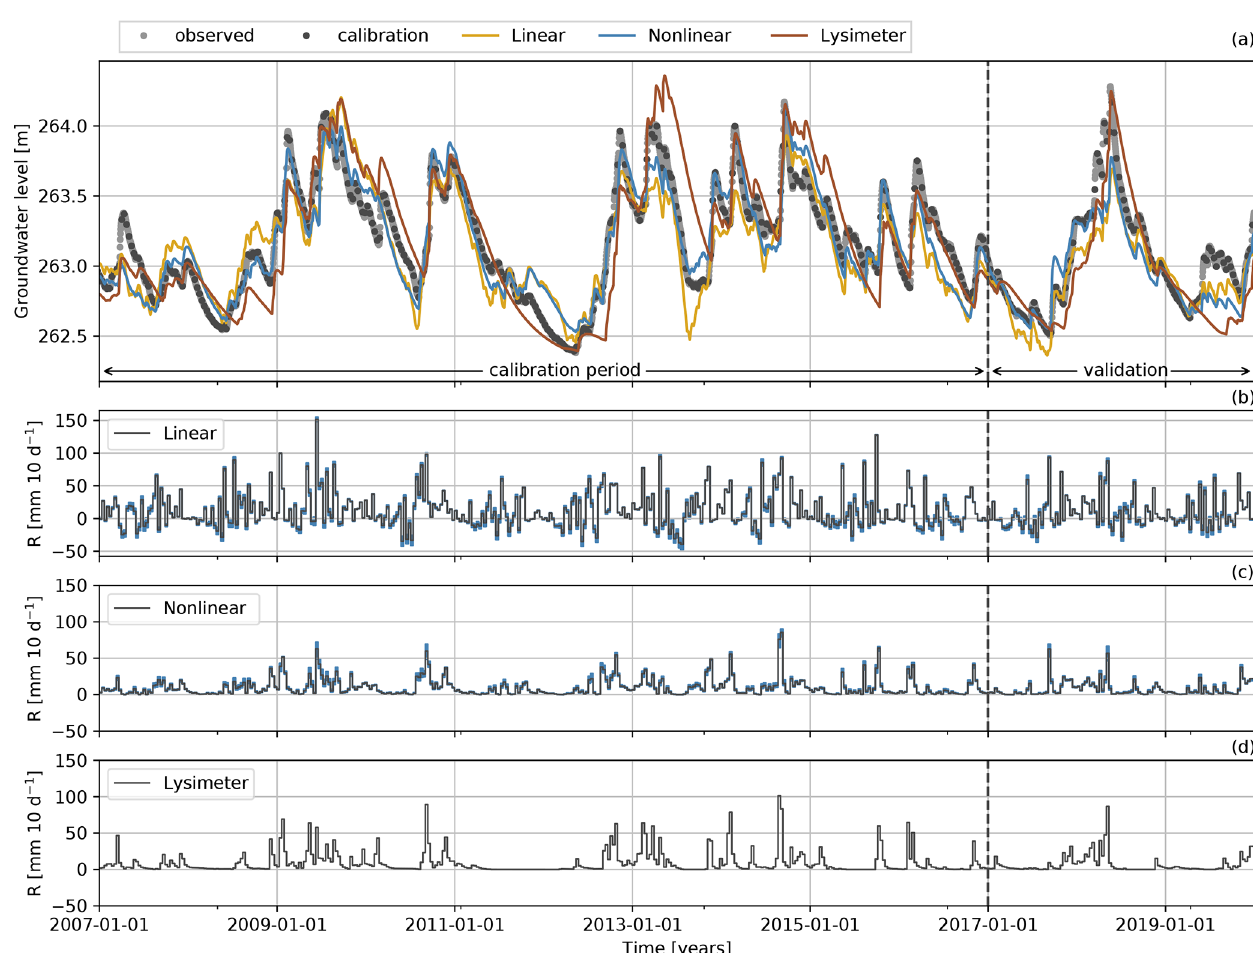
Figure 7. Observed and simulated groundwater levels (a) and the estimated (b, c) and measured (d) recharge rates ( R ). The groundwater- level measurements used for calibration are shown as black dots, and unused measurements are shown as gray dots. The blue shading in plots (b) and (c) denotes the 95% confidence intervals of the recharge estimates.